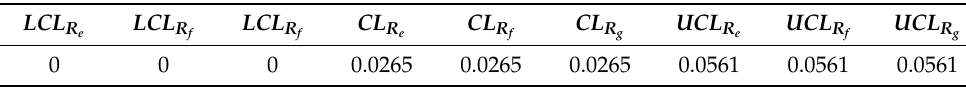
Table 5. Fuzzy R control limit with fuzzy C pk